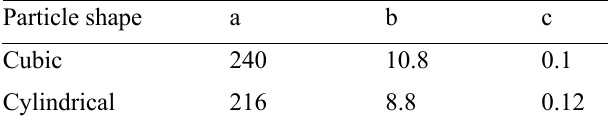
Table 3. Coefficients in equation (7)